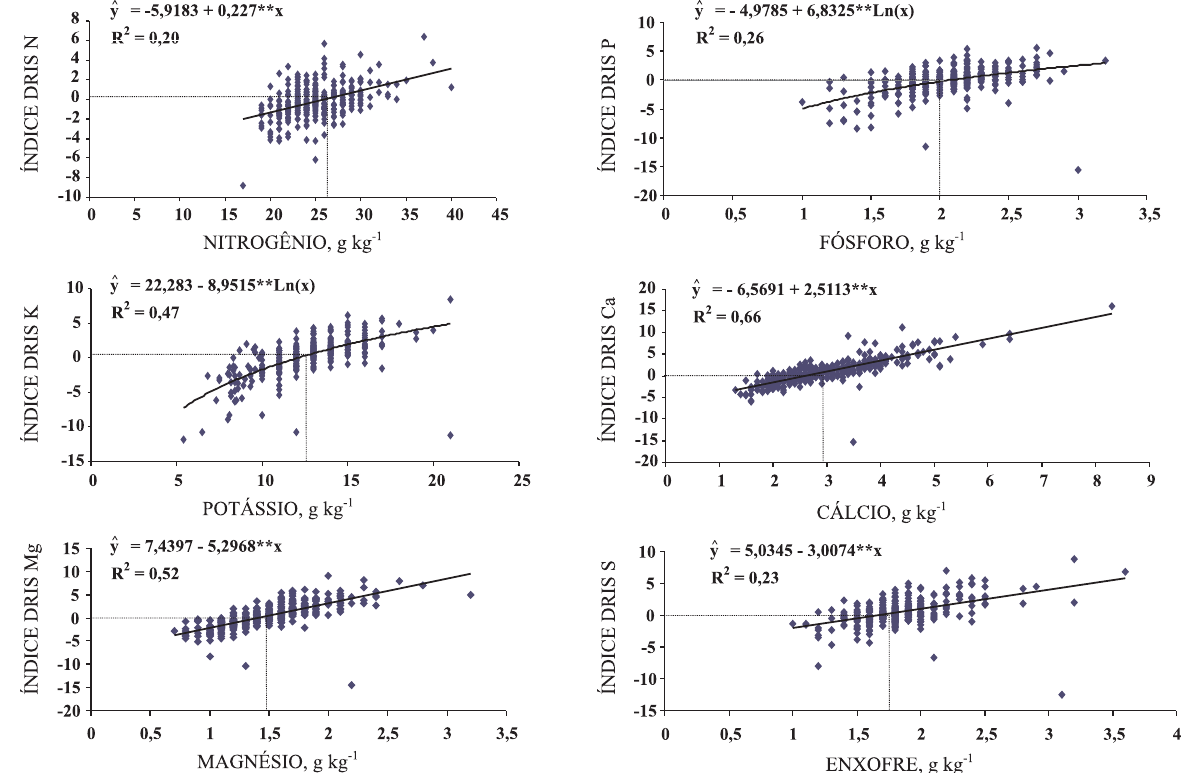
Figura 2. Relação entre os índices DRIS e a concentração de macronutrientes nas folhas de lavouras de arroz irrigado por inundação do Rio Grande do Sul, safra